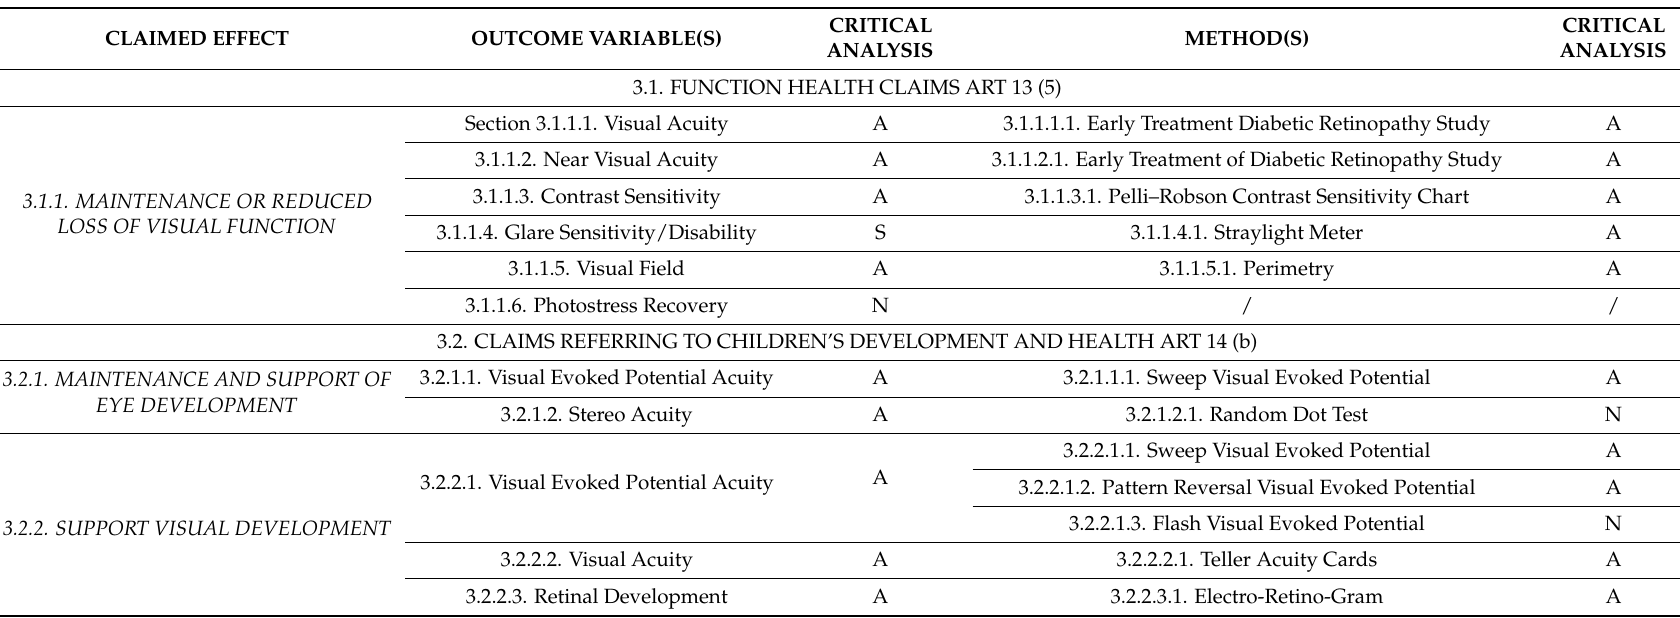
Table 2. Summary of the main findings of the study. Legend: A: appropriate itself; S: only supportive; N: not appropriate for that claimed effect; /: not evaluated (because the outcome variable is not appropriate per